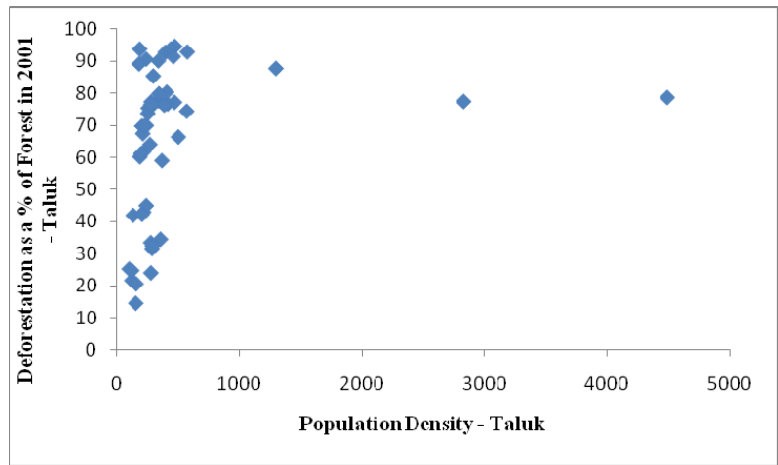
Figure 7b. Relationship between population density and the distribution of deforestation as a percentage of the forest area existing in 2001, for